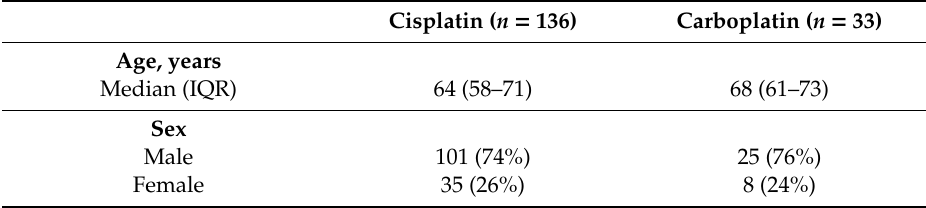
Table 2. Demographic and clinical details of patients receiving cisplatin vs.